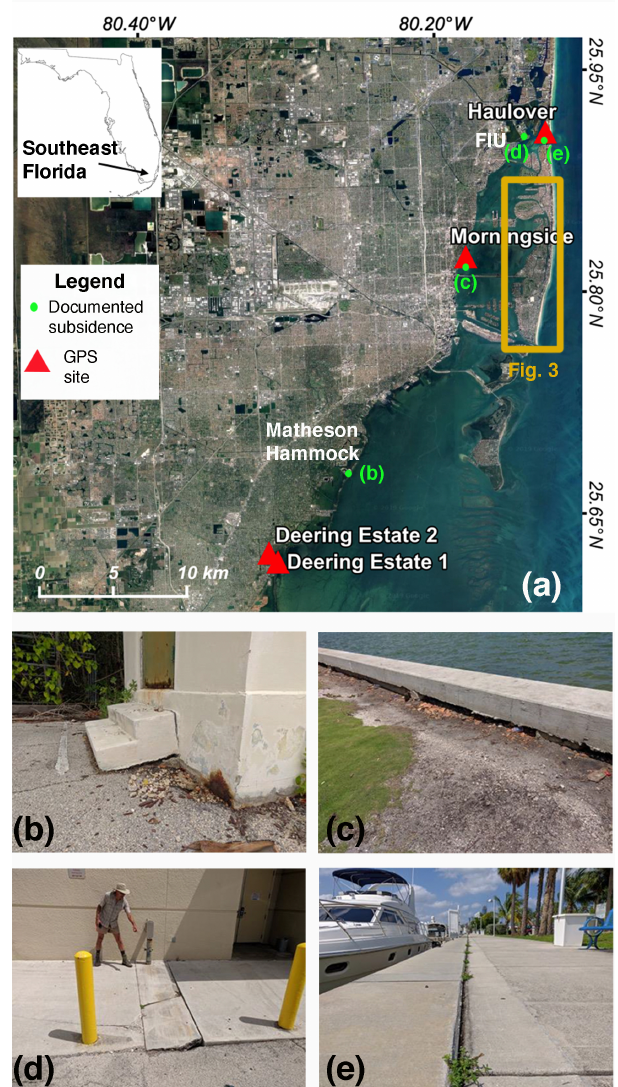
Figure 2. (a) Location map of our study area in southeast Florida based on a ©Google Map imagery. The map shows the location of documented coastal subsiding areas and planned GPS sites. In- sert shows the location of the study area with respect to state of Florida. (b) Subsidence-induced structural damage to a building in Matheson Hammock Park. (c) Observed subsidence along seawall in Morningside Park. (d) Subsidence-induced structural damage at the entrance to the Kovens Conference Center at the Biscayne Bay Campus of Florida International University (FIU). (e) Observed subsidence along seawall in Haulover